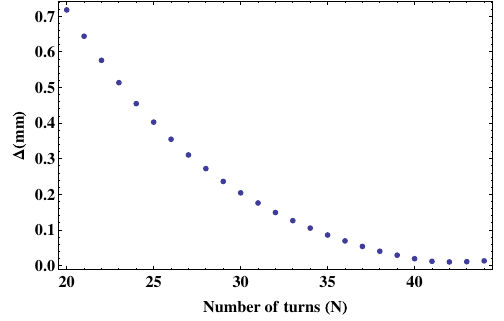
FIG. 7. The mean absolute error ( Δ ) vs total number of turns used in reconstructing the momentum